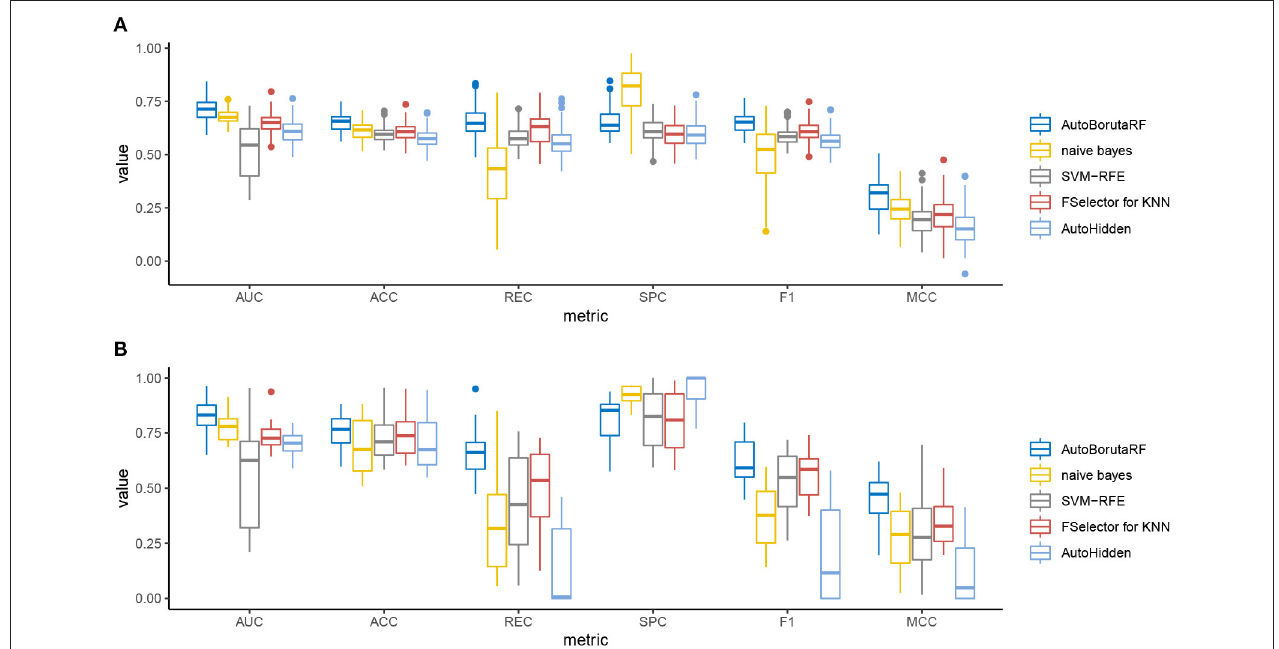
FIGURE 3 | Box plots of the six evaluation metrics overall the cell lines in the (A) GDSC and (B) CCLE datasets. Our method was of the best performance with respect to AUC, accuracy, recall, specificity, F 1 score, and Matthews correlation coefficient. The naive Bayes classifier and SVM-RFE outperformed at specificity.